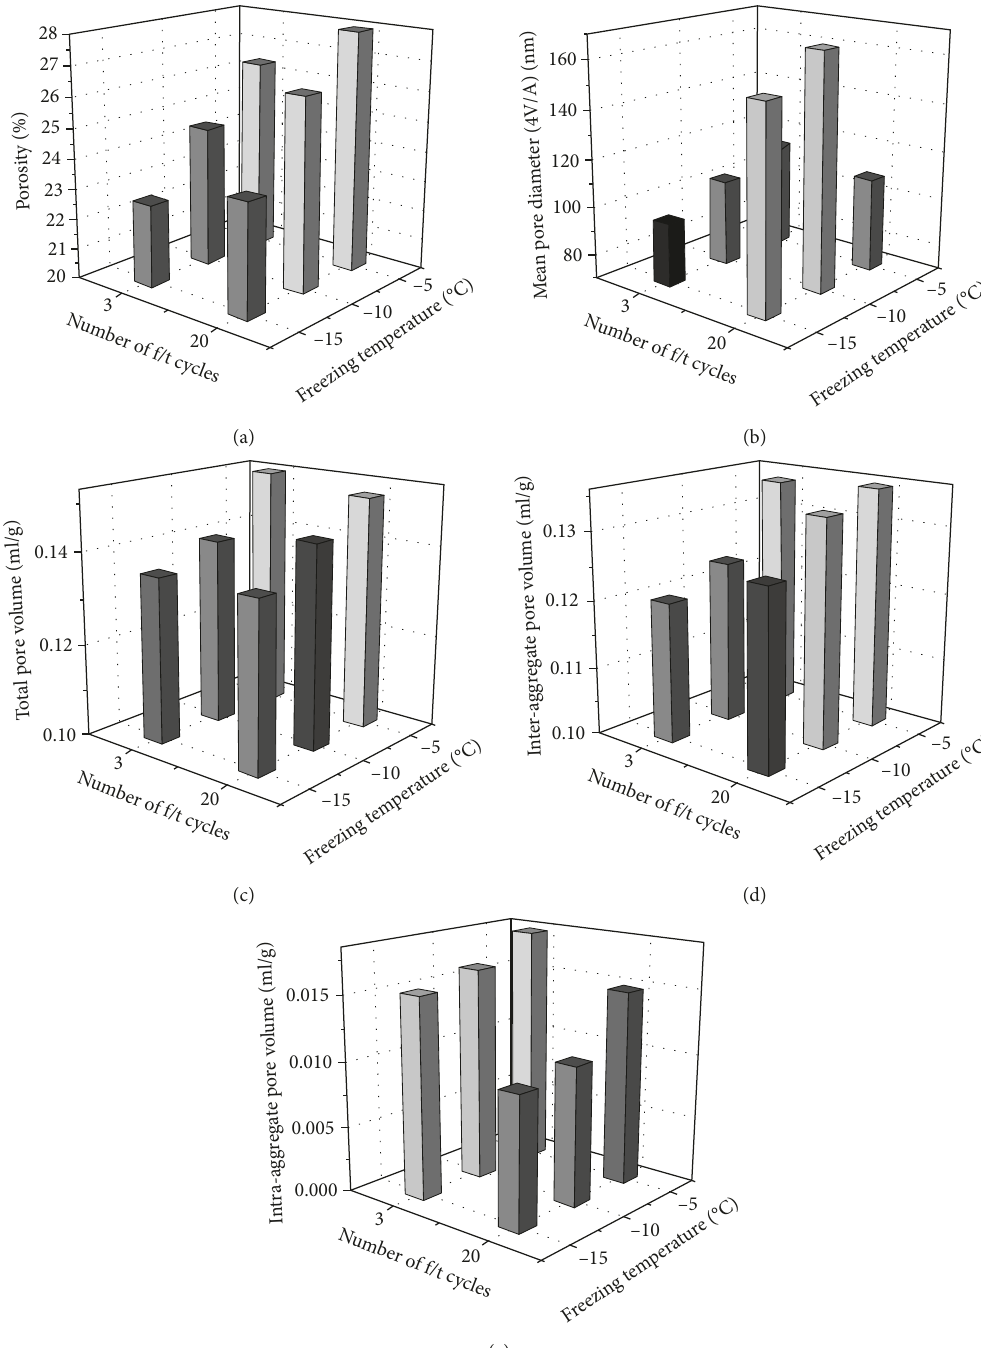
Figure 6: Histograms of pore data of soil samples. (a) Porosity. (b) Mean pore diameter. (c) Total pore volume. (d) Inter-aggregate pore volume. (e) Intra-aggregate pore